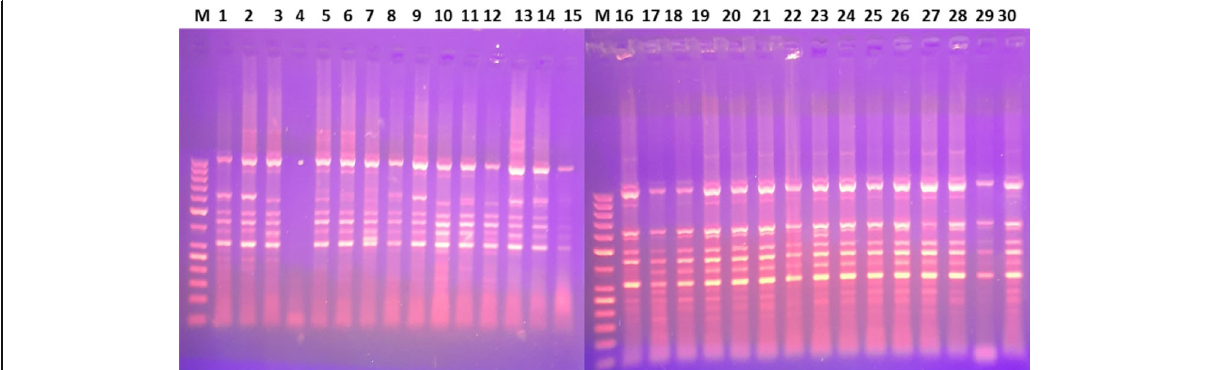
Fig. 1 TRAP profiling of thirty sweet sorghum genotypes amplified with COMT/Em2 primer combination in a 1.5% Agarose gel compared with